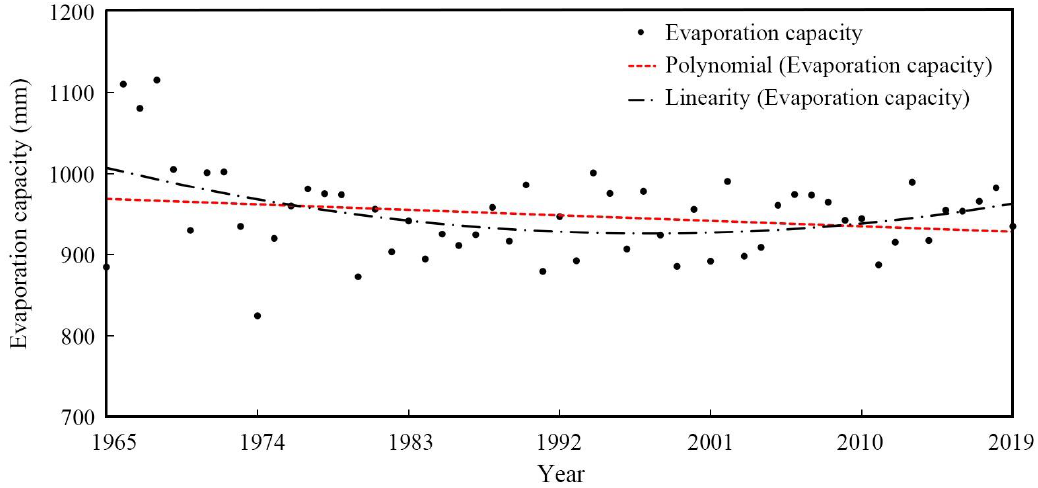
Figure 5. Annual evaporation simulation.